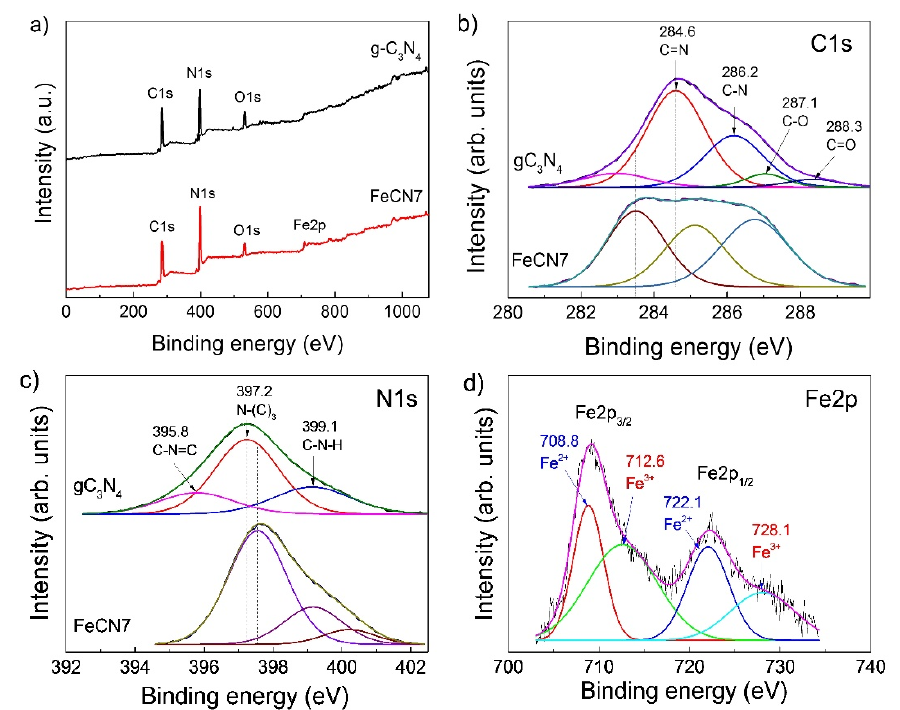
Figure 8. ( a ) X-ray photoelectron (XPS) survey spectra and ( b ) XPS spectra of C1s, ( c ) N1s and ( d ) Fe2p of pure g-C 3 N 4 and FeCN7 photocatalyst.